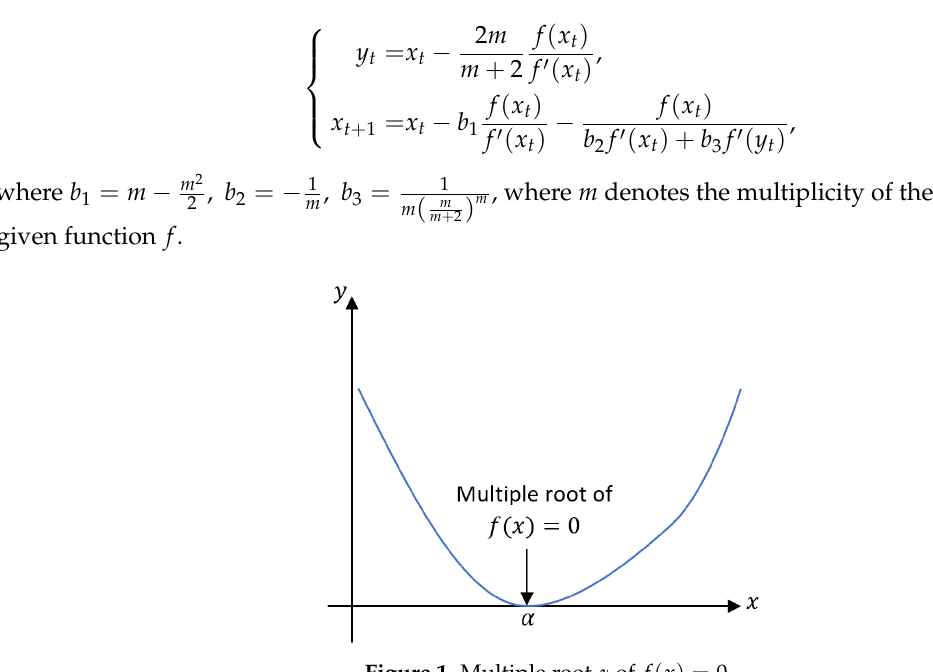
Figure 1. Multiple root α of f ( x ) =